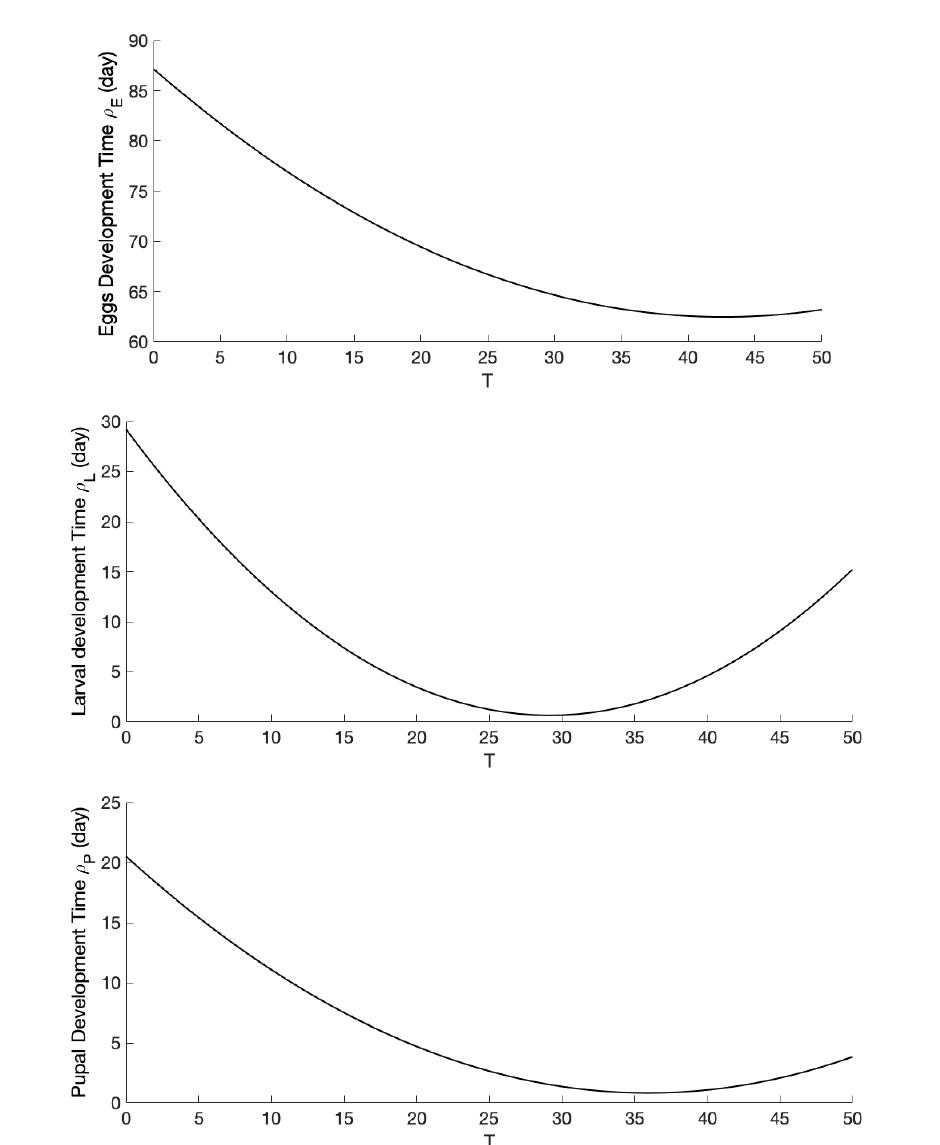
Figure A3. Juvenile stages’ development time, eggs ρ E , larvae ρ L , and pupae ρ P as they vary with the temperature range of 0 ◦ C to 50 ◦ C